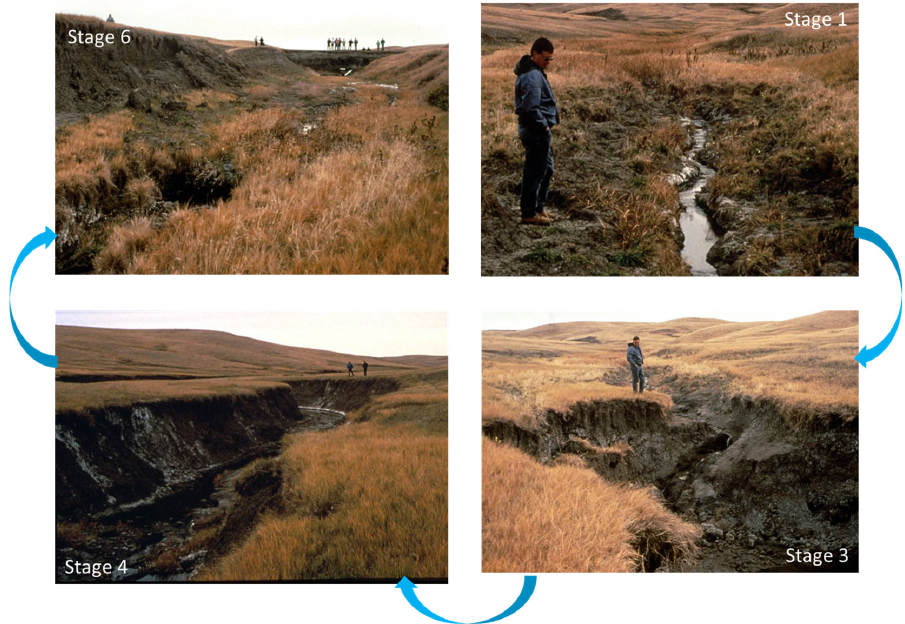
Figure 2. Example stream evolution from South Dakota (see Figure 3 for stream stage description) (photos courtesy of Lyle